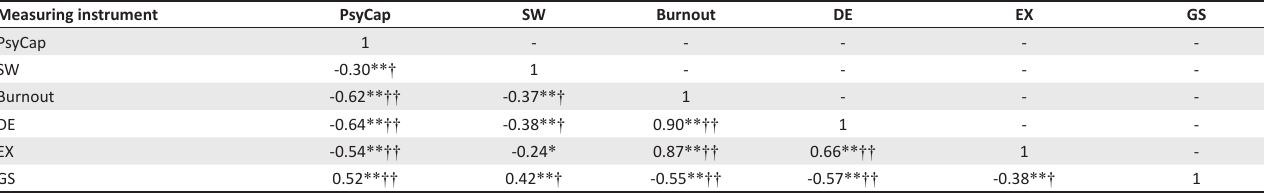
TABLE 4: Correlations between the scales and factors. Measuring instrument